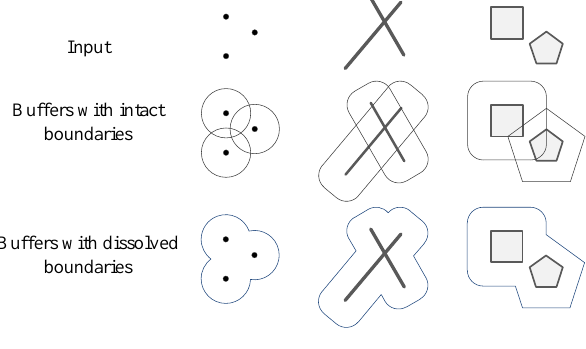
Figure 1. Two types of vector